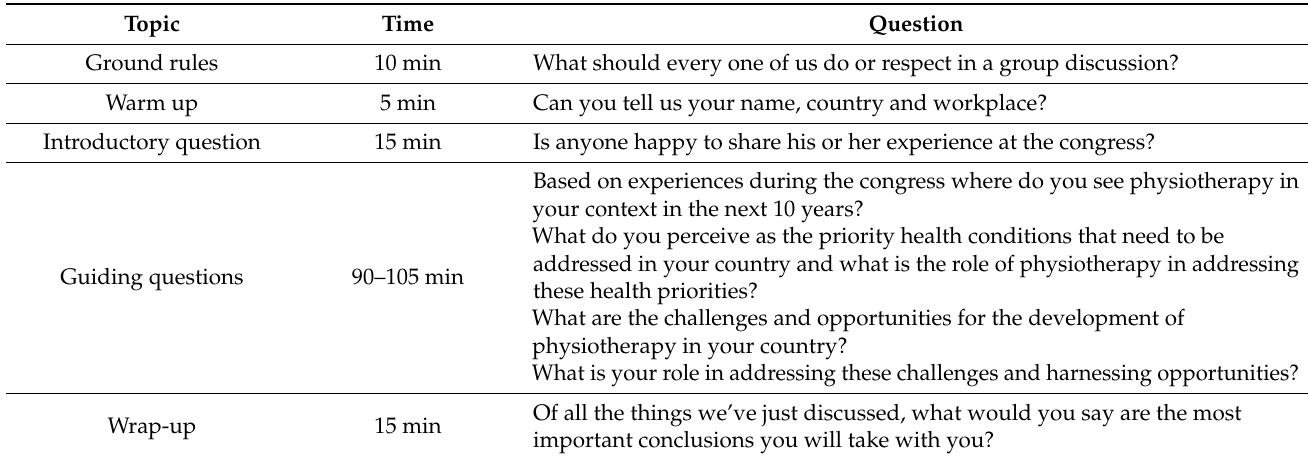
Table 2. Guiding questions for FGD